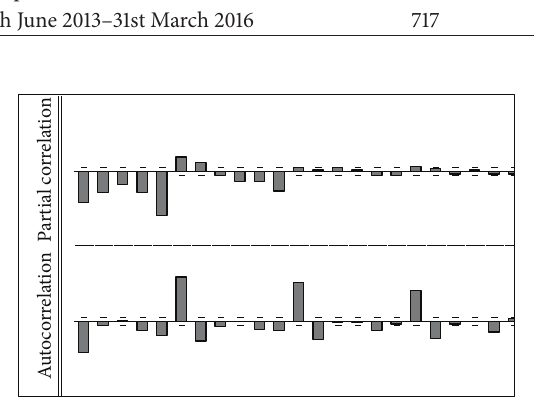
Figure 4: Correlogram of the preintervention series.